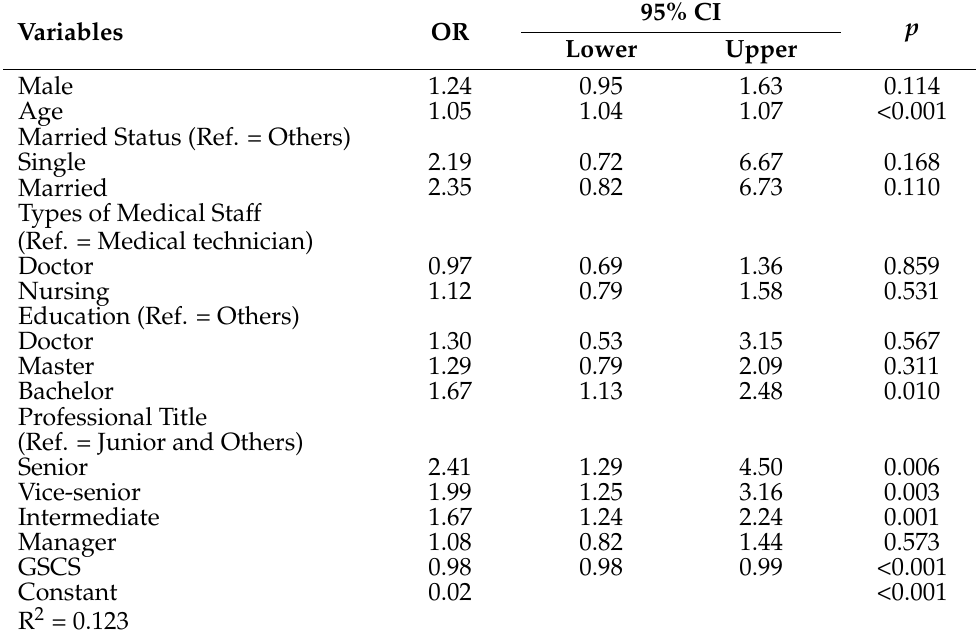
Table 4. Logistic regression for the effect of general social capital on physical